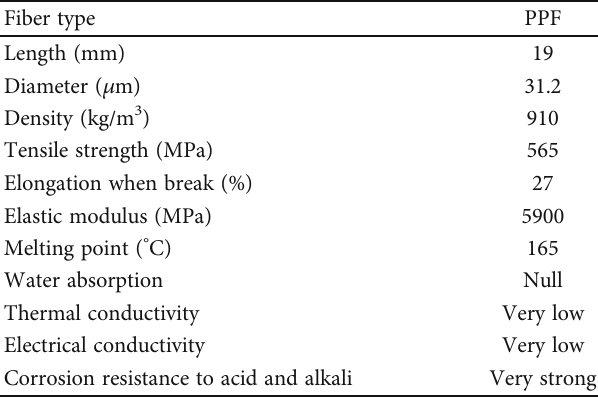
Table 1: Physical properties of